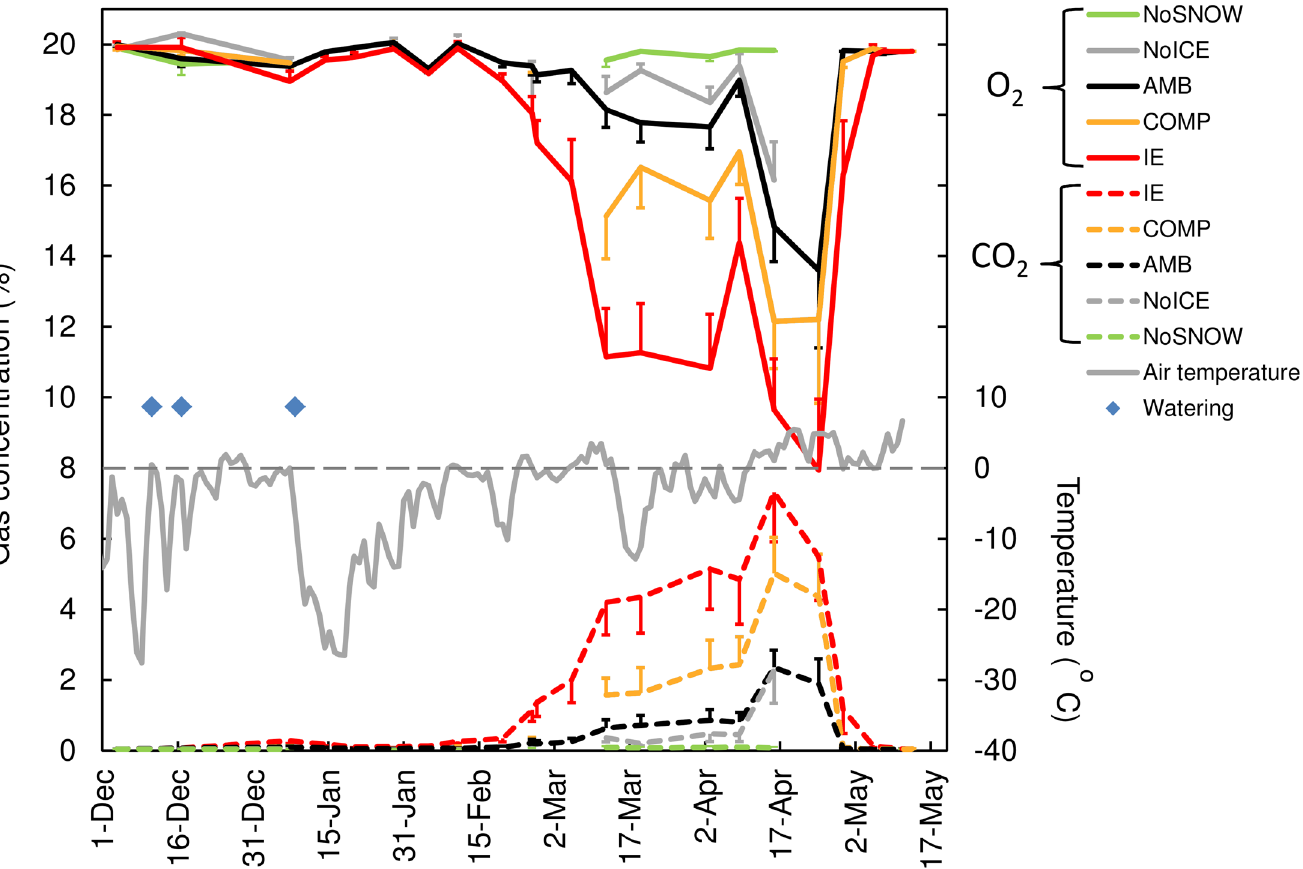
Fig 3. Effect of snow manipulation on CO 2 and O 2 concentrations 2-cm deep in humus layer. Mean daily air temperature at field site is depicted. Snow watering occasions are indicated by blue diamonds. For better clarity, one-sided error bars are depicted. Values are means ± SE (n = 10).